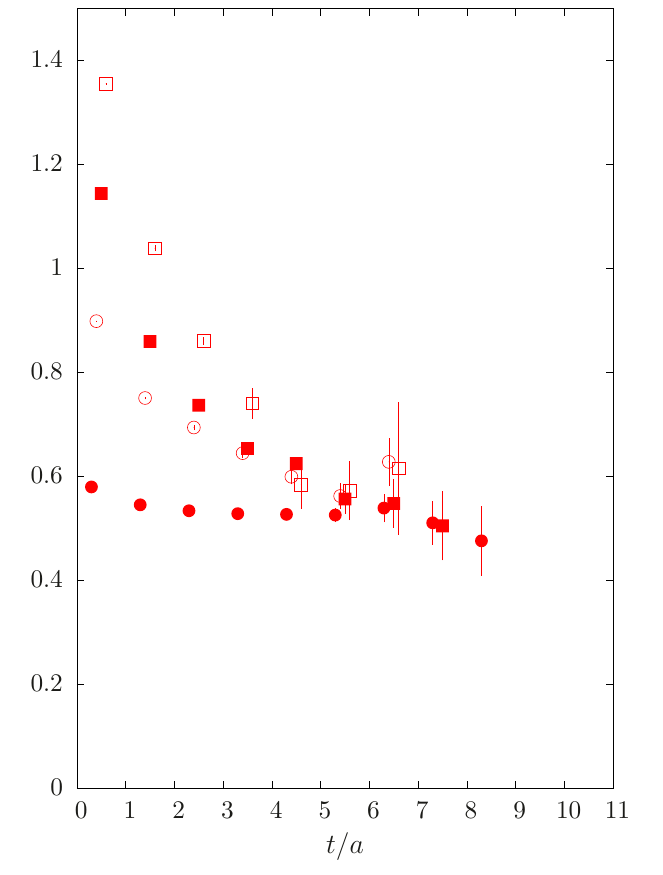
Figure 10 . E(cid:11)ective energies of the particle-like state in the Pfa(cid:14)an ‘string’ spectrum in SO(4) at (cid:12) = 15 : 1 for lengths l = 18 ;